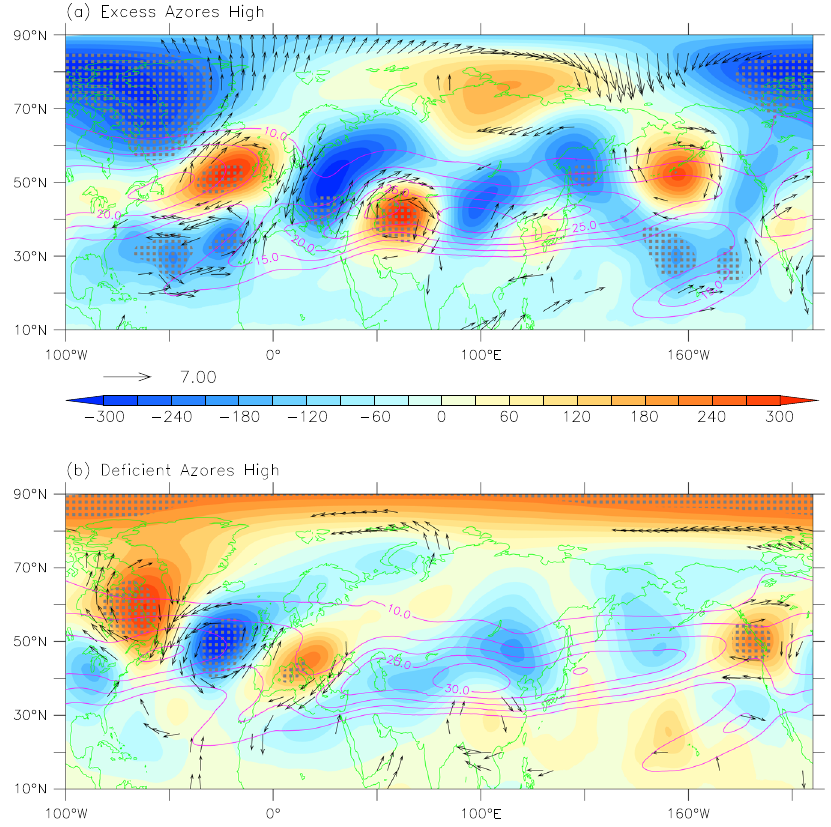
Fig. 4 Composite of Azores High. Composite anomaly of 200-hPa GPH (shaded), 95% statistical signi fi cance of composite of GPH (grey dots) and wind (black arrows) and composite of zonal wind >5 ms − 1 (Cray contours) for a excess and b de fi cient years of AH,